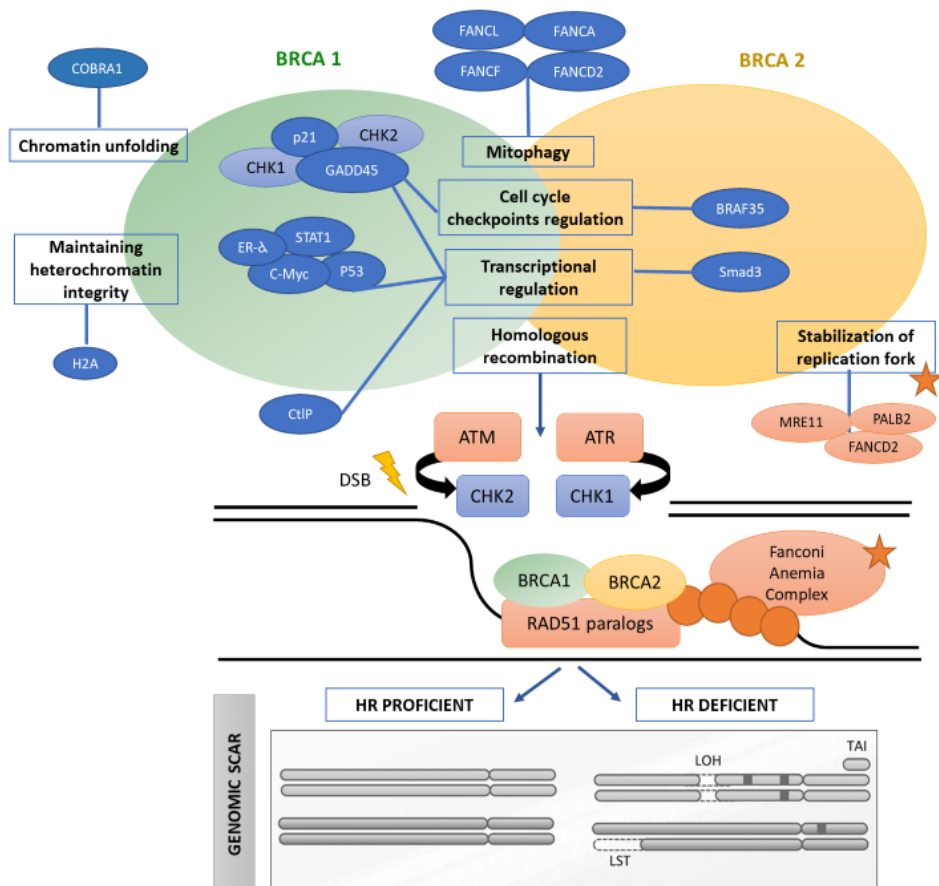
Figure 1. Functional features of proteins involved in HRD. Adapted with permission from